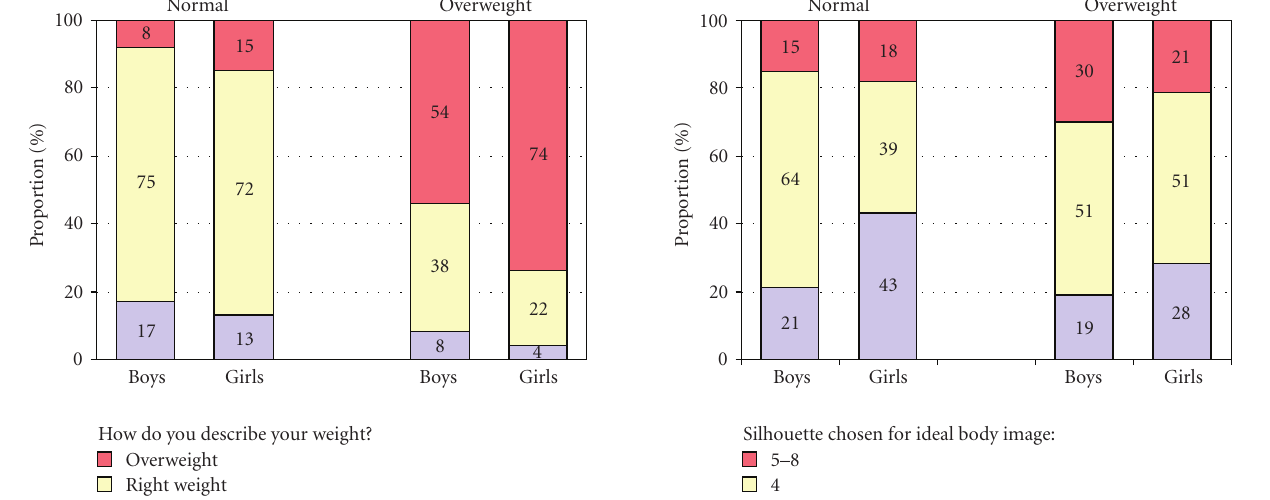
Table 3: Association between body image discrepancy (BID) and weight-control behavior. Normal weight Overweight